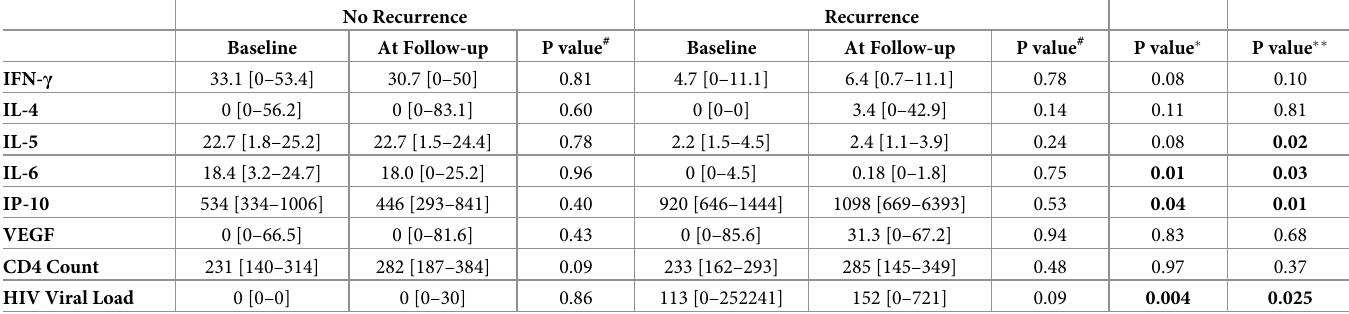
Table 3. Comparison of cytokine/chemokine levels and HIV-related parameters in individuals experiencing recurrence versus those in remission. No Recurrence Recurrence Baseline At Follow-up P value # Baseline At Follow-up P value # P value � P value